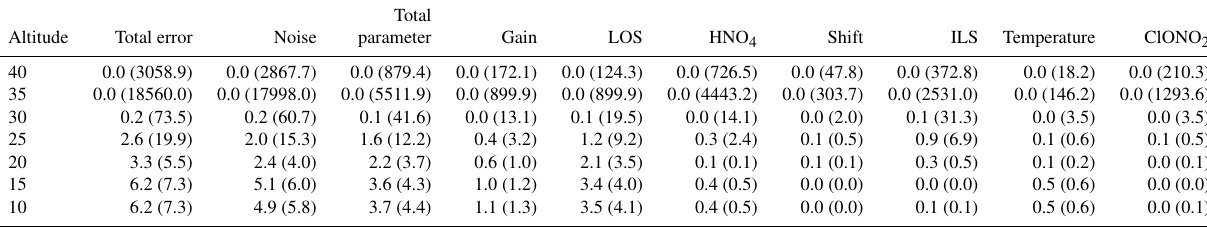
Table A4. Error estimates for an equatorial profile during the RR period. Errors are given in pptv (relative errors in